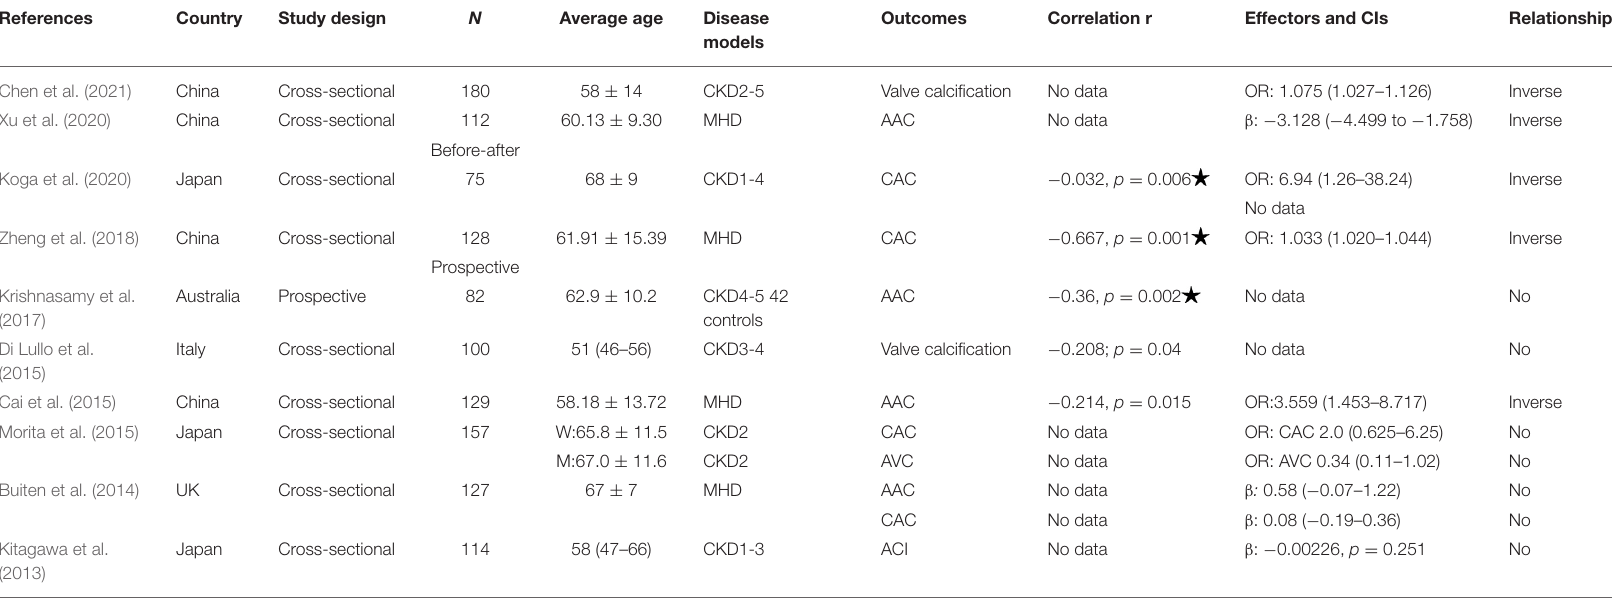
TABLE 1 | Characteristics of the included